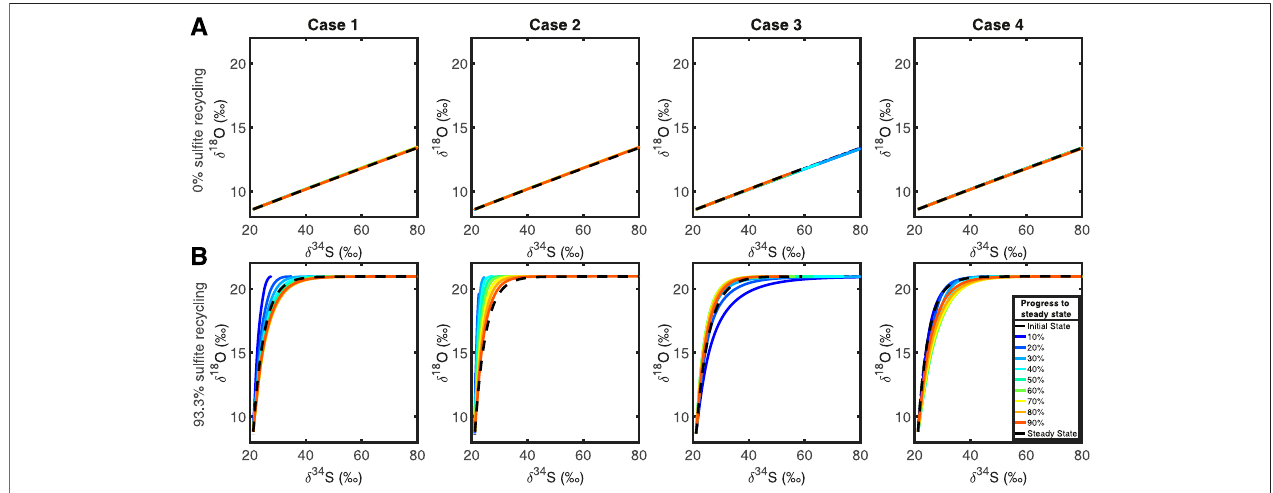
FIGURE 4 | Top row, (A) : plots showing the evolution of the δ 34 S and δ 18 O cross plots through time, in each test case, for r (cid:2) 0, which corresponds to 0% of the sul fi te is being recycled. Bottom row, (B) : in order, test cases 1, 2, 3, and 4 when 93.3% of sul fi te is being recycled.